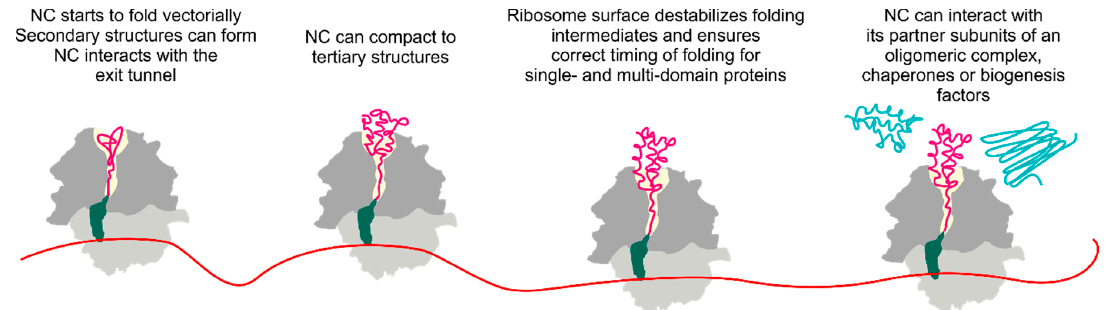
Figure 1. Schematic of cotranslational protein folding. Folding begins early inside the polypeptide exit tunnel. The nascent chain (NC) emerging from the ribosome can interact with chaperones, biogenesis factors, or other proteins. Small and large ribosomal subunits are shown in light and dark gray, respectively; the tRNA (green) with the nascent peptide (magenta) is shown as the ribosome moves along the mRNA (red) and the growing nascent chain moves through the polypeptide exit tunnel (light yellow). Protein partners interacting with the nascent peptide are depicted in blue.